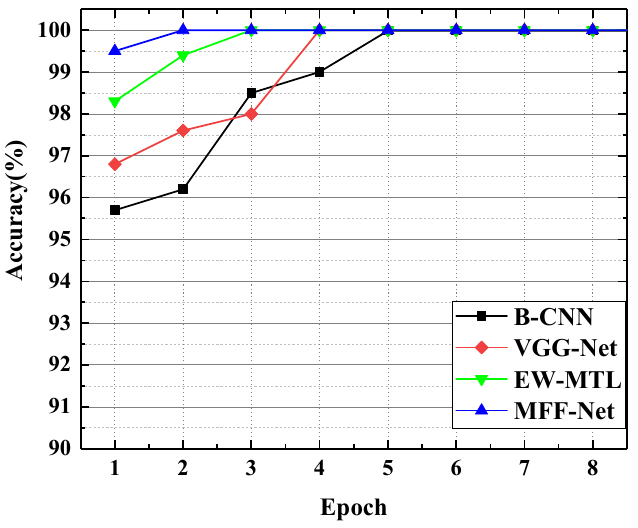
Figure 5. The MFI accuracies at different epochs for different models.